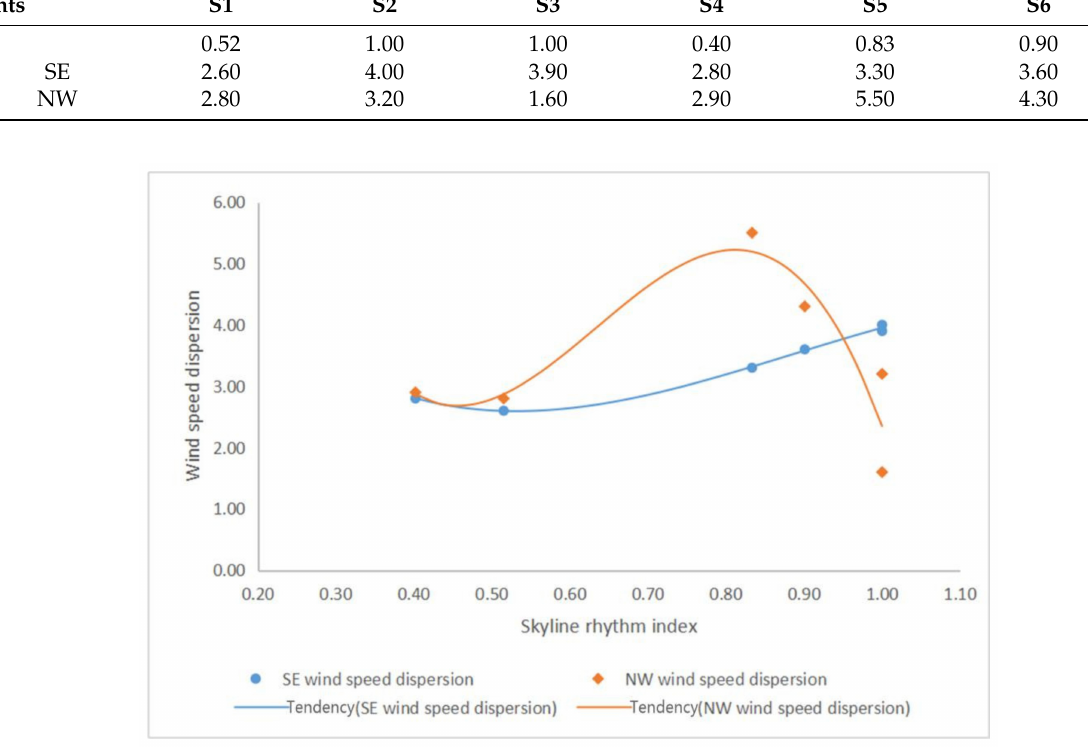
Figure 24. The relationship between wind speed dispersion and skyline rhythm